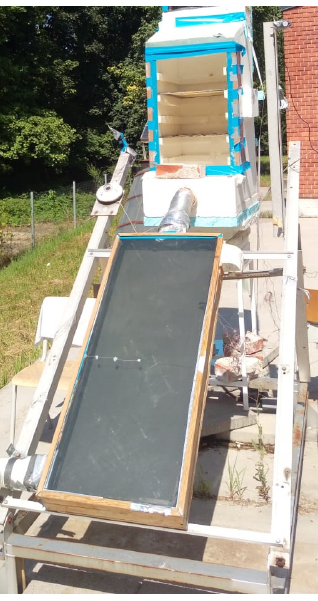
Figure 2. A flat plate collector assembled with a solar dryer.